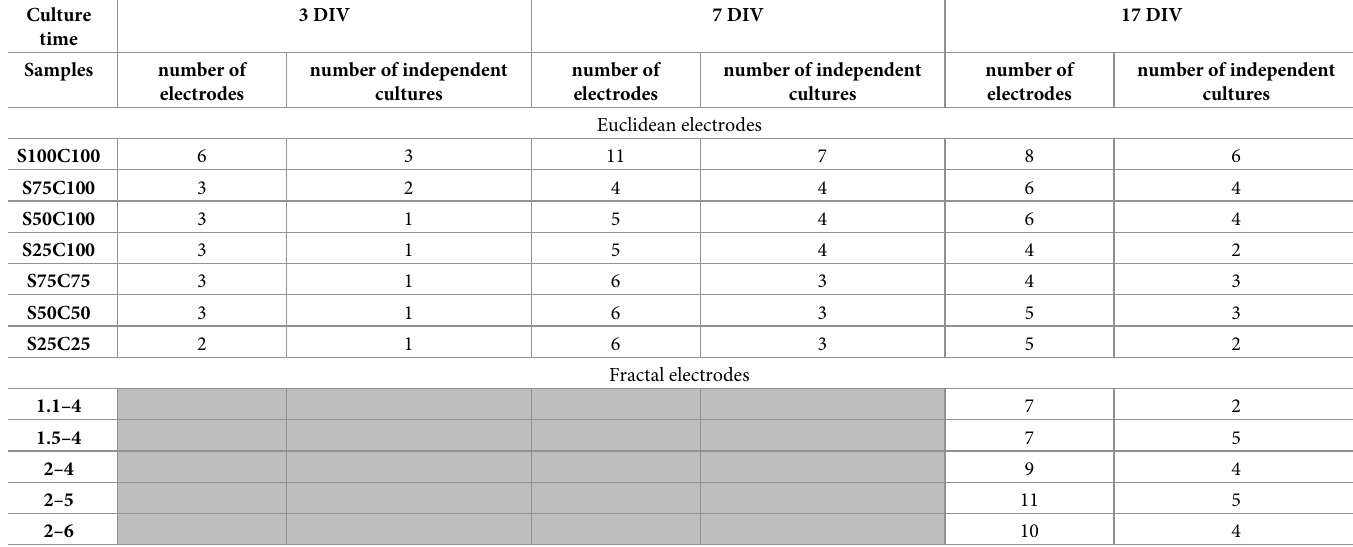
Table 3. Total number of each electrode geometry used in these experiments as well as number of independent cultures including each electrode design.